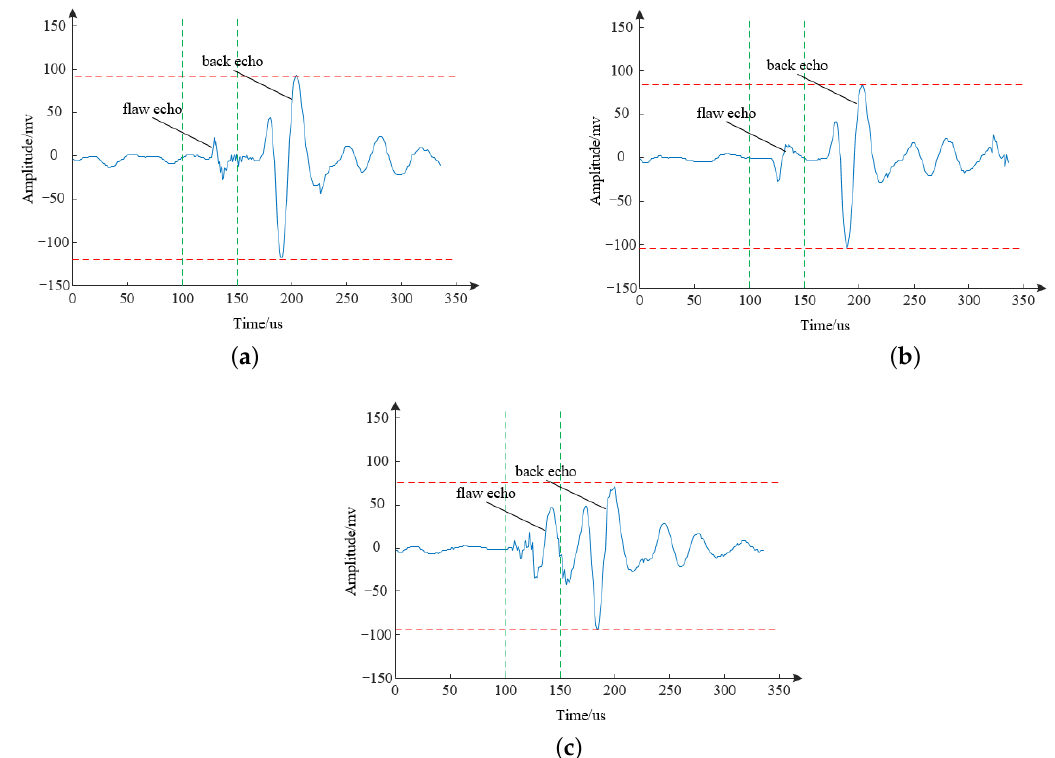
Figure 11. Different ultrasonic echo (( a ) defect-free echo, ( b ) near-surface defect echo, and ( c ) internal defect